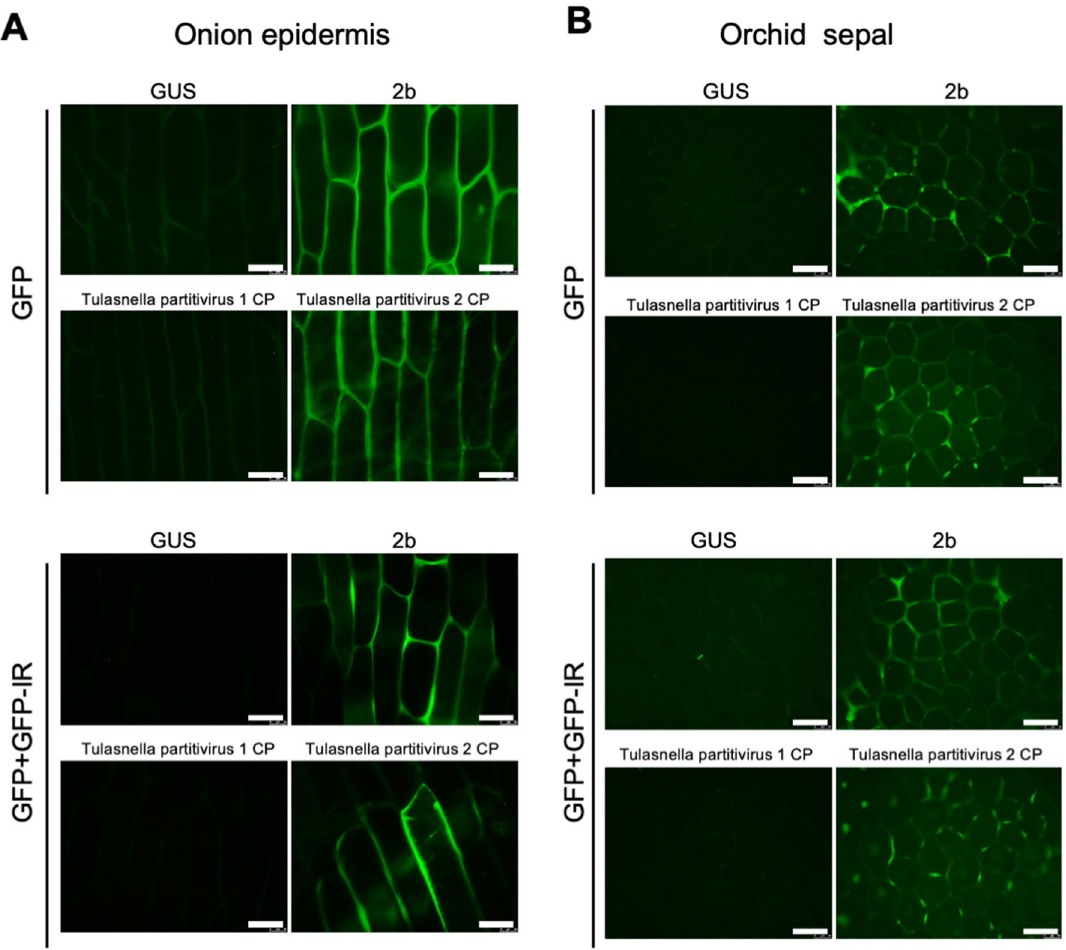
Figure 5. RSS activity of partitivirus CPs in onion and orchid cells. GFP and partitivirus CPs were co-expressed with or without GFP-IR by agroinfiltration in onion epidermis ( A ) and Phalaenopsis aphrodite sepal tissues ( B ). Images were taken under UV using an epifluorescence microscope at 3 dpa. Scale bars: 50 μm. CMV 2b and GUS were used as a positive and negative control,